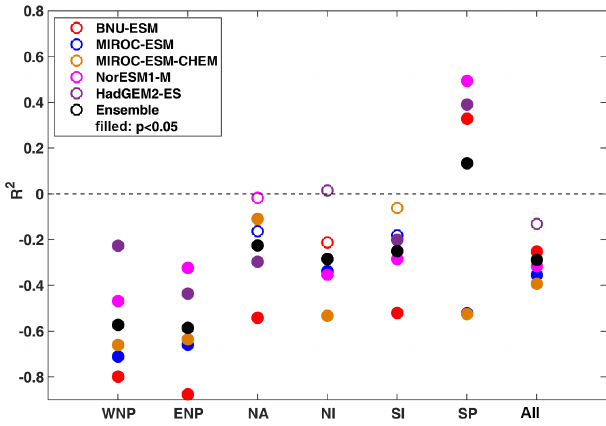
Figure 2. The correlation coefficients ( R 2 ) between annual GPI and VI anomalies (G4 − RCP4.5) during TC season and six ocean TC basins. The MIROC-ESM-CHEM model has four ensemble mem- bers, the HadGEM2-ES model has three ensemble members, and other models have one member. Each model is weighted equally and normalized for the ensemble regardless of the number of sepa- rate realizations. The dashed line represents R 2 =